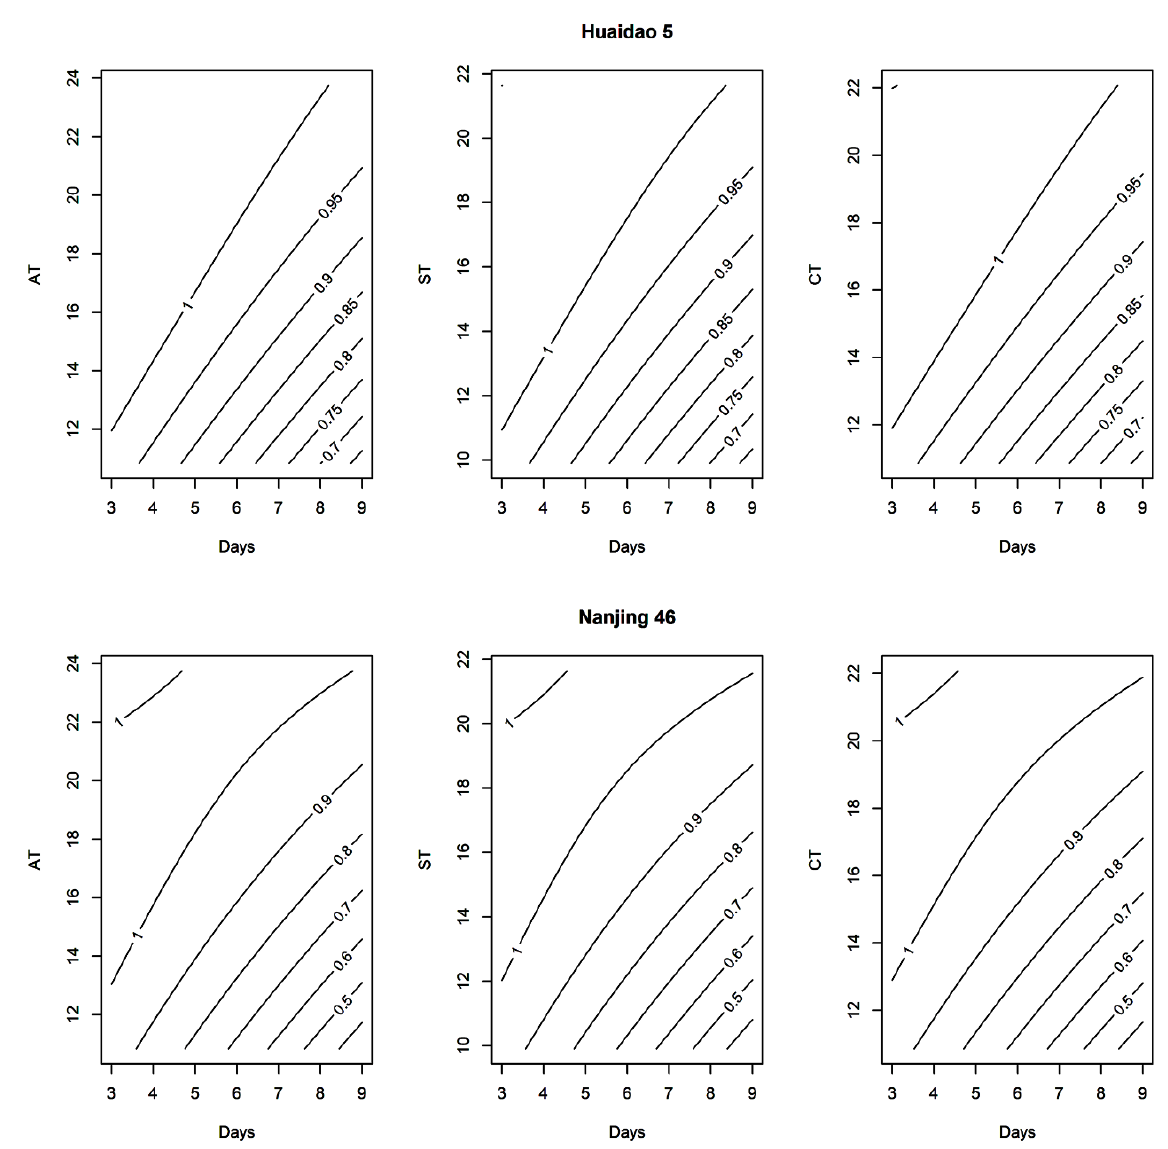
Figure 3. Contour plots for relative change in yield per plant (YPP) under decreasing low air temperature (AT), soil temperature (ST) and canopy temperature (CT) with increasing low-temperature stress (LTS) duration at flowering stage in Huaidao 5 and Nanjing 46.